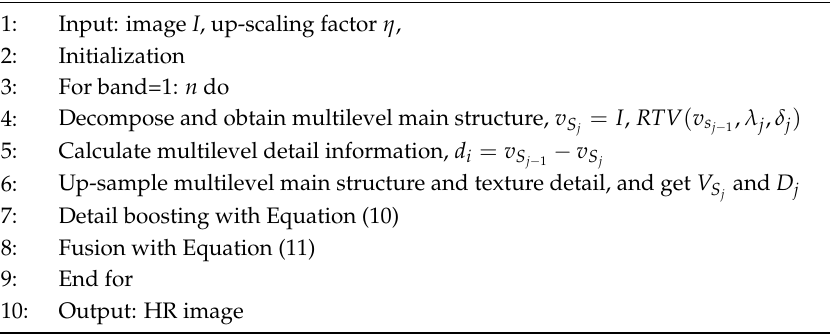
Algorithm 1. Multilevel Main Structure and Detail-Boosting